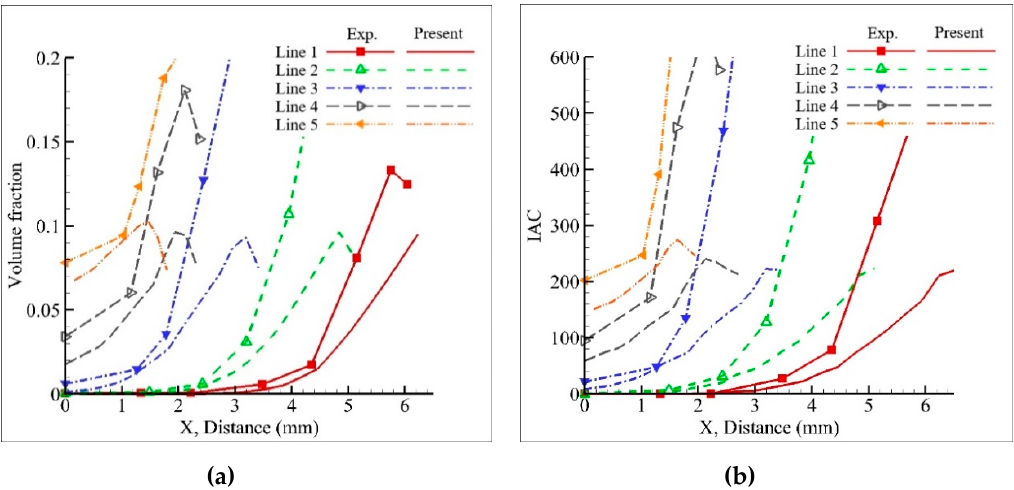
Figure 8. Case 2 numerical results of Lines 1–5 compared with experiment results: ( a ) volume fraction and ( b ) interfacial area concentration.